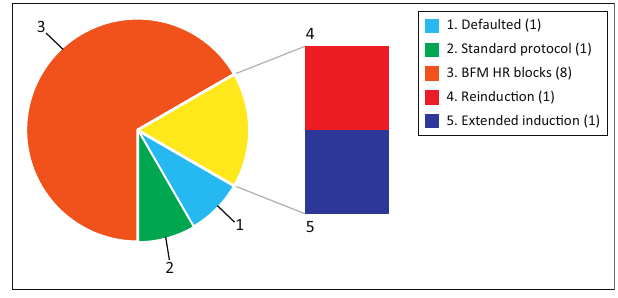
FIGURE 5: Clinical decision based on positive minimal residual disease ( %